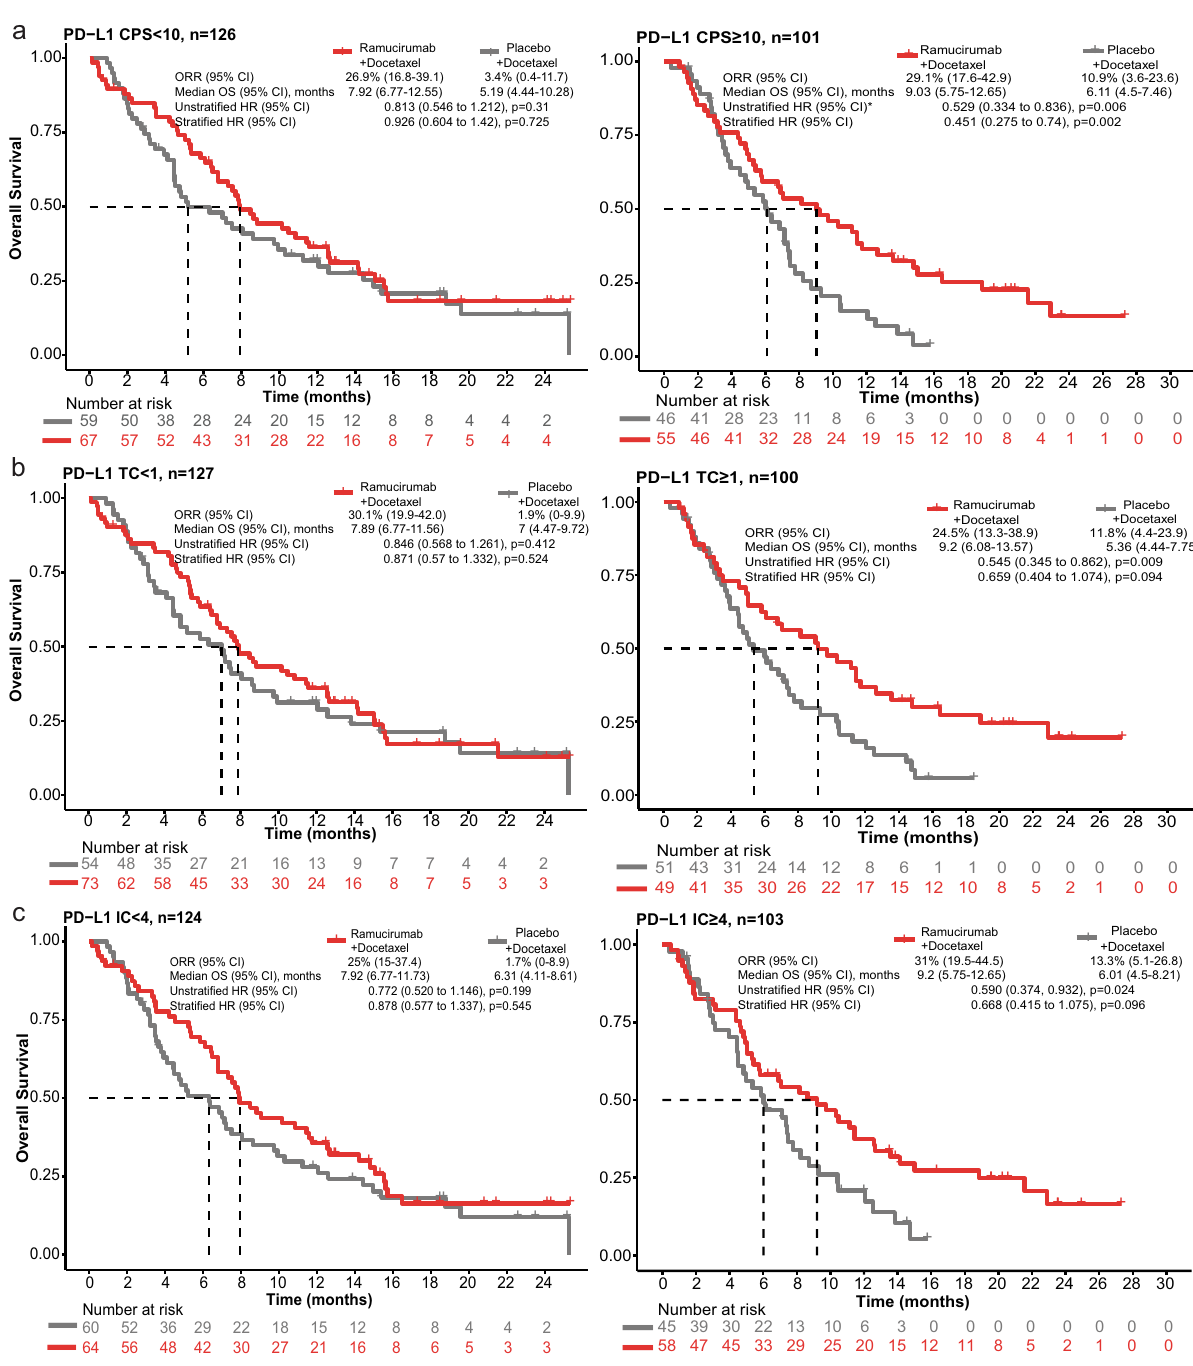
Fig. 1 Biomarker association with clinical outcome: PD-L1 and signature pathways. a – c Kaplan – Meier curves depicting OS probability in ramucirumab + docetaxel or placebo + docetaxel arms based on PD-L1 expression. PD-L1 scoring method and cutoffs scored by a CPS < 10 ( n = 126 participants) vs. ≥ 10 ( n = 101 participants), b TC < 1 ( n = 127 participants) vs. ≥ 1 ( n = 100 participants), and c IC < 4 ( n = 124 participants) vs. ≥ 4 ( n = 103 participants). ORR, median OS, and strati fi ed/unstrati fi ed HRs are shown. Strati fi cation was based on geographical region, baseline ECOG PS, and visceral metastases. A two-sided Wald test was used in Cox regression models. p -values before BH-adjustment are shown in fi gures. p -values after BH-adjustment are shown in Supplementary Table 1. For all models, the TR1 population ( n = 227 participants) is used, and the number within each subset is reported above. *Indicates proportional hazard assumption was violated with p = 0.04. Source data are provided as a Source Data fi le. BH, Benjamini-Hochberg; CI, con fi dence interval; CPS, combined positive score; ECOG PS, Eastern Cooperative Oncology Group Performance Status; HR, hazard ratio; IC, immune cell; n, number of participants; ORR, objective response rate; OS, overall survival; PD-L1, programmed cell death ligand 1; TC, tumor cell; TR, translational